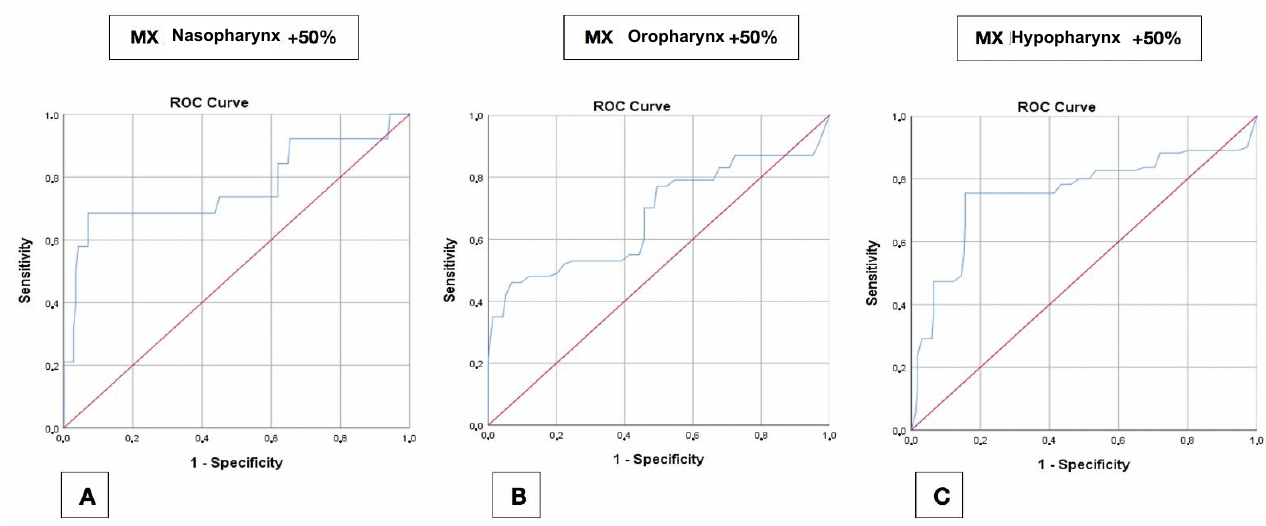
Figure 5. ROC curves relative to the +50% area increase; maxillary displacement for the three subregions analysed. ( a ) Nasopharynx. ( b ) Oropharynx. ( c ) Hypopharynx.